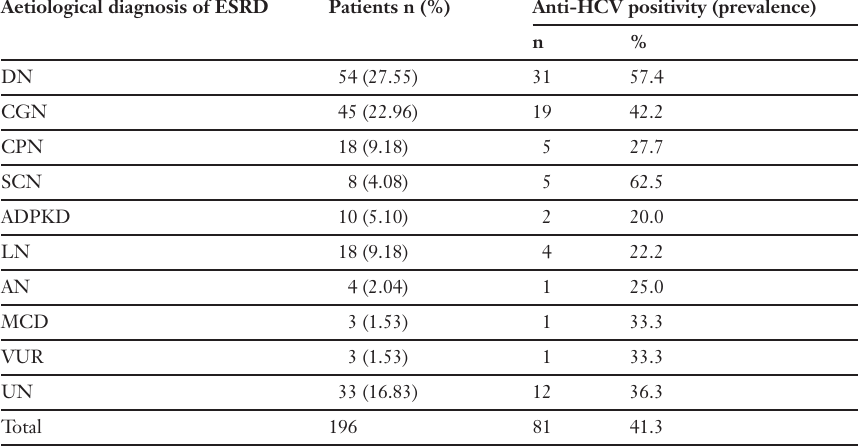
Aetiological diagno- sis and anti-HCV pos- itivity (prevalence) in the study popula- tion on long-term haemodialysis (n =